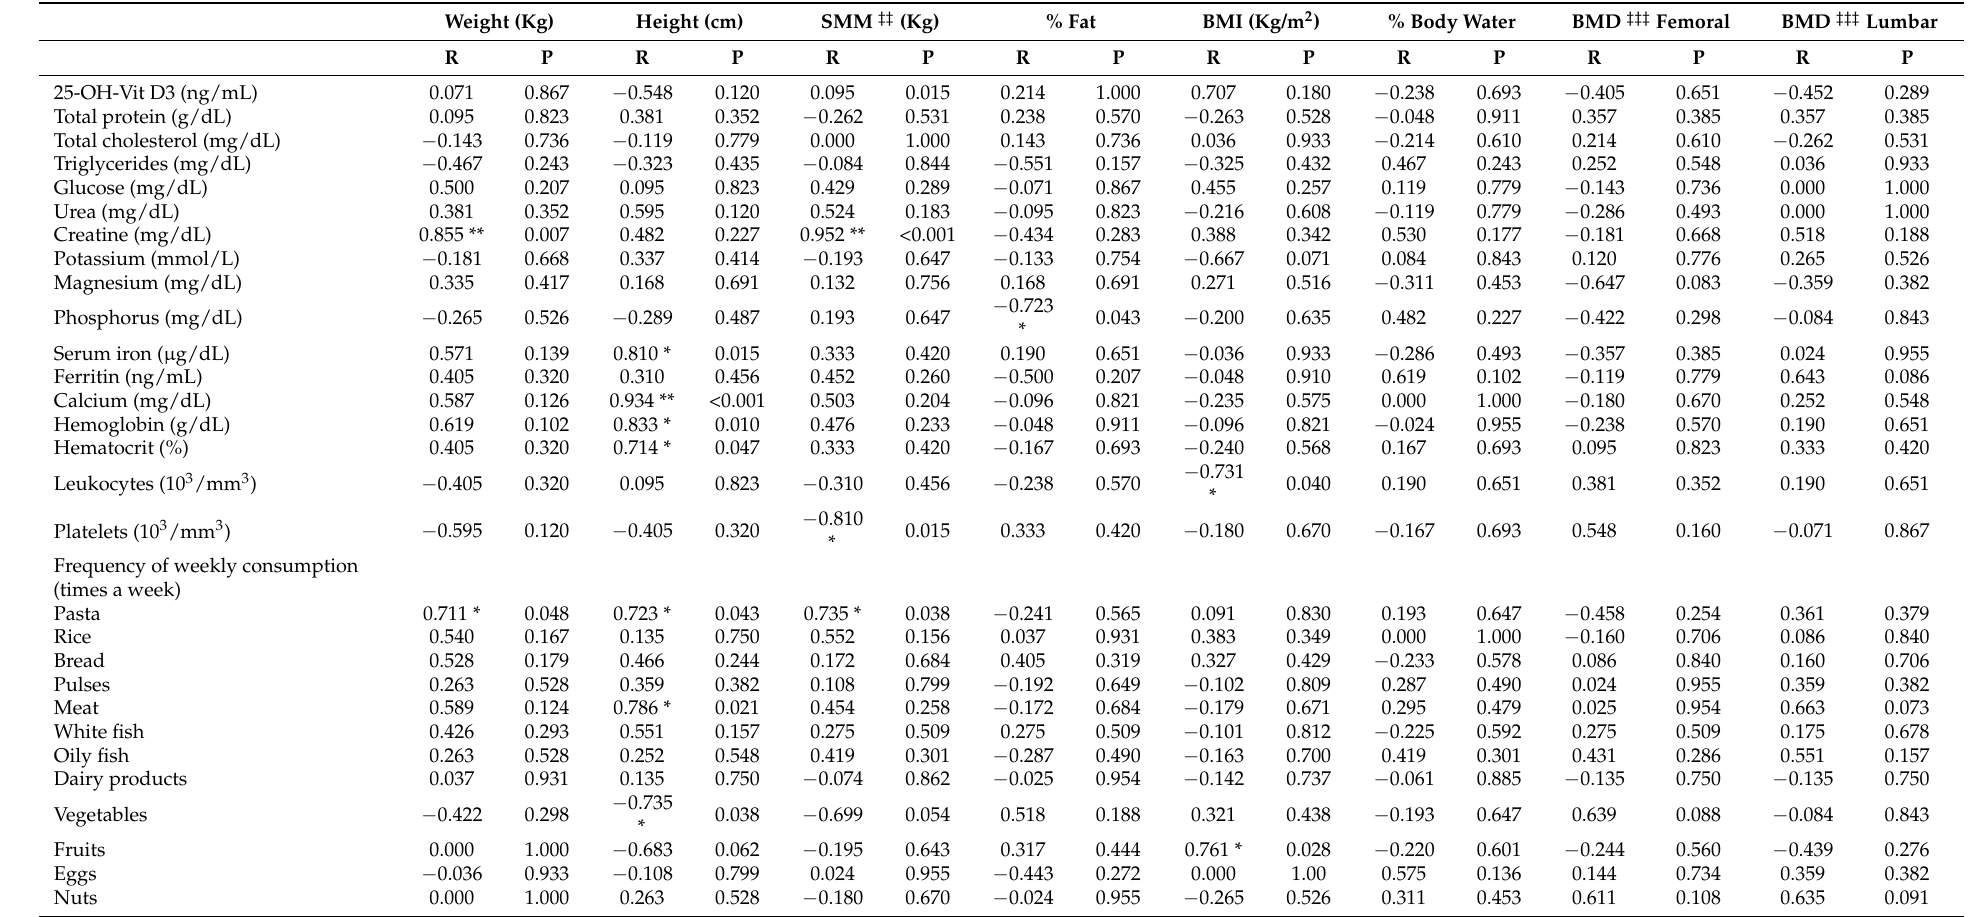
Table 4. Correlations ‡ of body composition variables under study with analytical and biochemical values and frequency of food